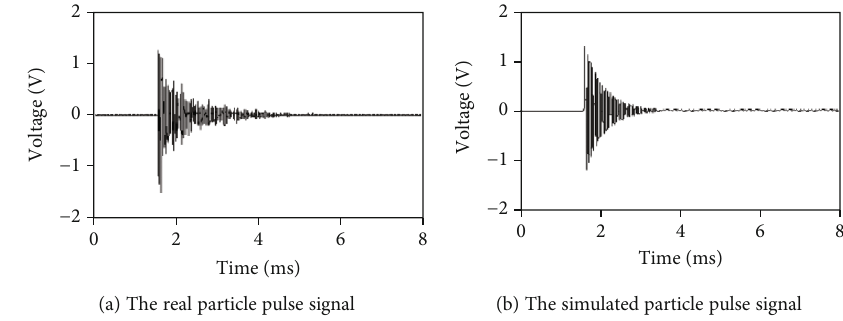
Figure 4: The real particle pulse signal and its simulating